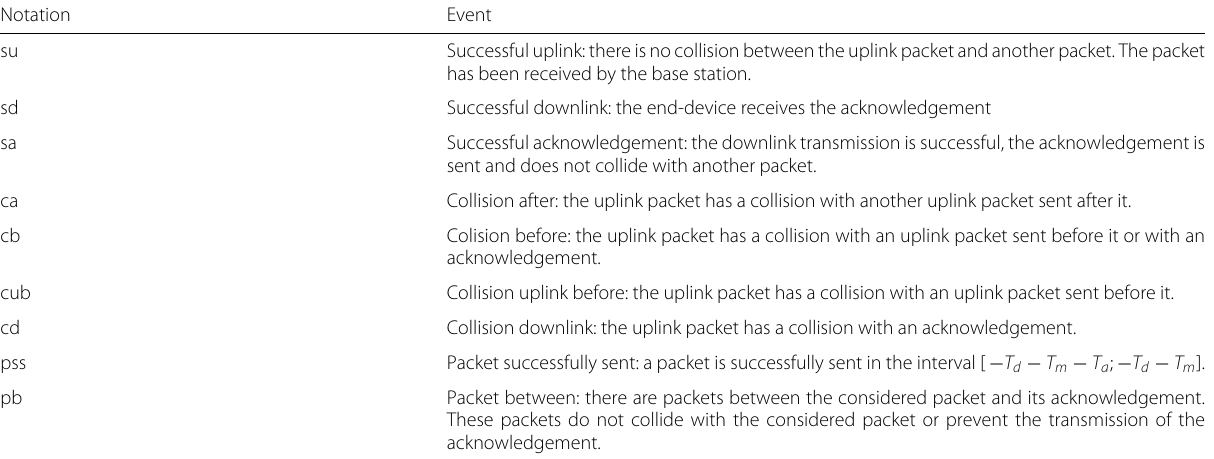
Table 1 Description of the events considered for the computation of the probability of successful transmission Notation Event